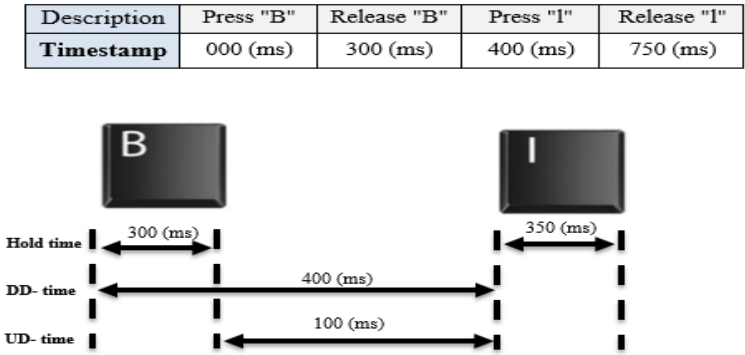
Figure 3. Example of extracting time features of keystroke dynamics .